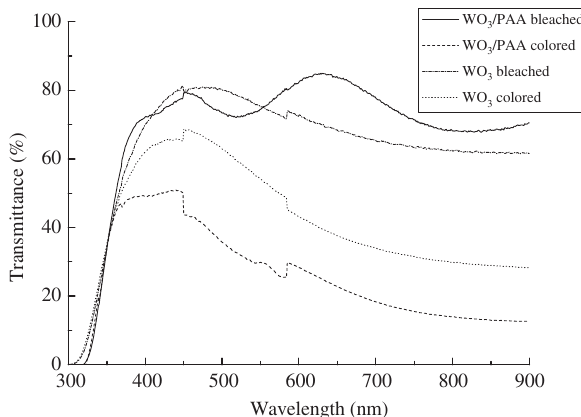
and PAA/WO com- 3 3